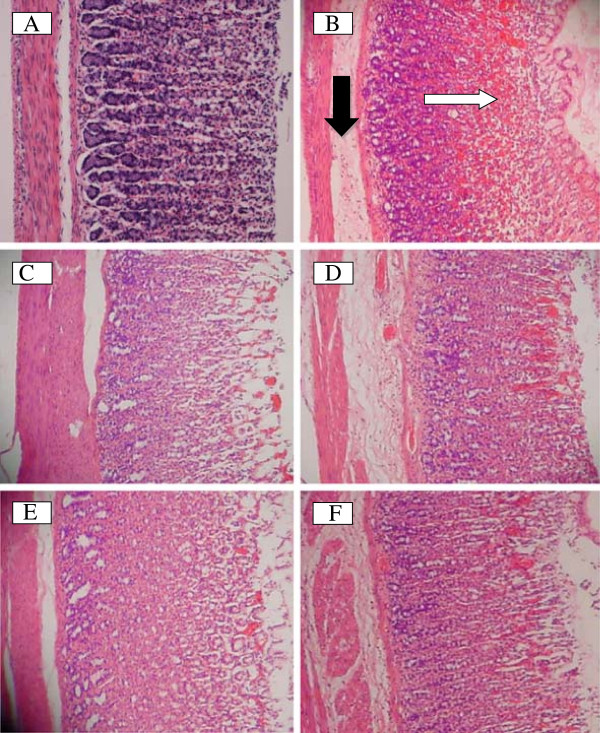
Histological evaluation. The gastric mucosa of the rats pretreated with DES at doses 5, 10, 20 mg/kg (D, E, F) or omeprazole (C) showed improved histological appearance compared to ulcer control rats (B) which have extensive visible hemorrhagic necrosis of the gastric mucosa with edema and leucocytes infiltration of submucosa. The black arrow indicates edema in submucosa and the white arrow indicates disruption to the deep mucosa layer. (A) showed normal histological apperance of the intact stomach from normal group. (H & E stain: 20×).